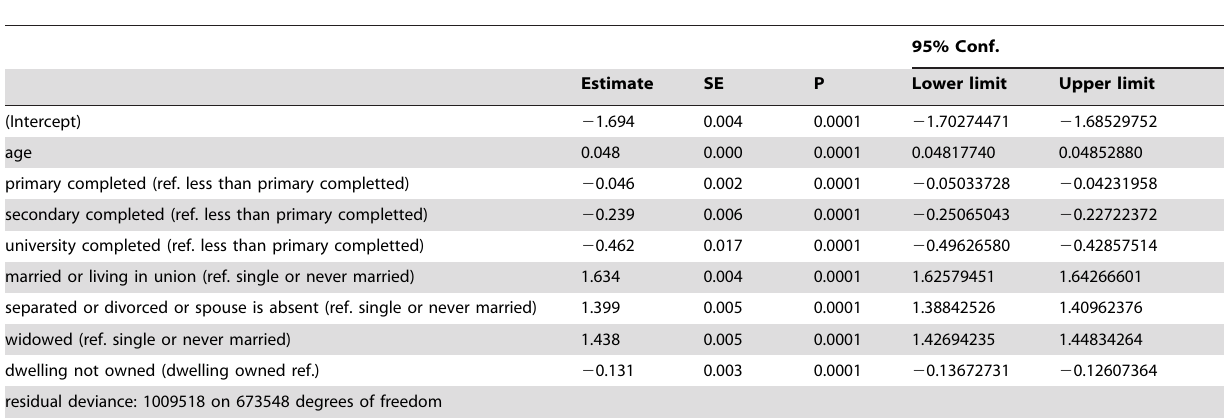
Table 4. GLM on basis of a quasi - poisson error structure, of age, education, marital status and ownership of dwelling regressing on the number of children